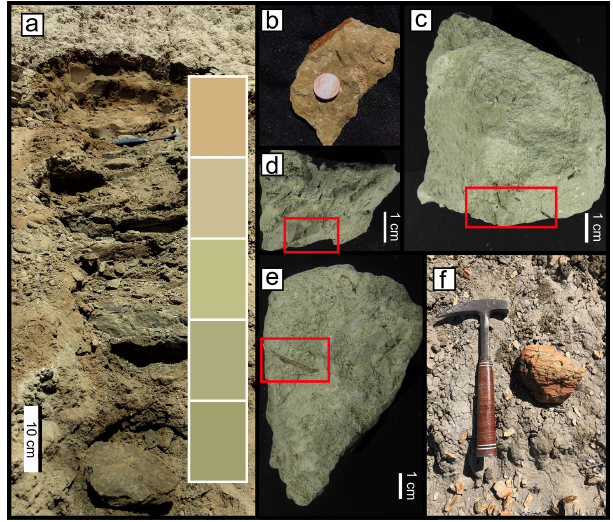
Figure 2. Paleosol images and features. (a) Full profile of 19BRWY3 with a rock hammer for scale, (b) drab-haloed root trace from 19BRWY-2UB, (c) A-horizon fine organic rootlets in red box from 19BRWY2UA, (d) slickensides on 19BRWY1UA, (e) rhi- zoliths from 19BRWY1UA, and (f) mineralized wood with a rock hammer for scale, excavated ∼ 3m above